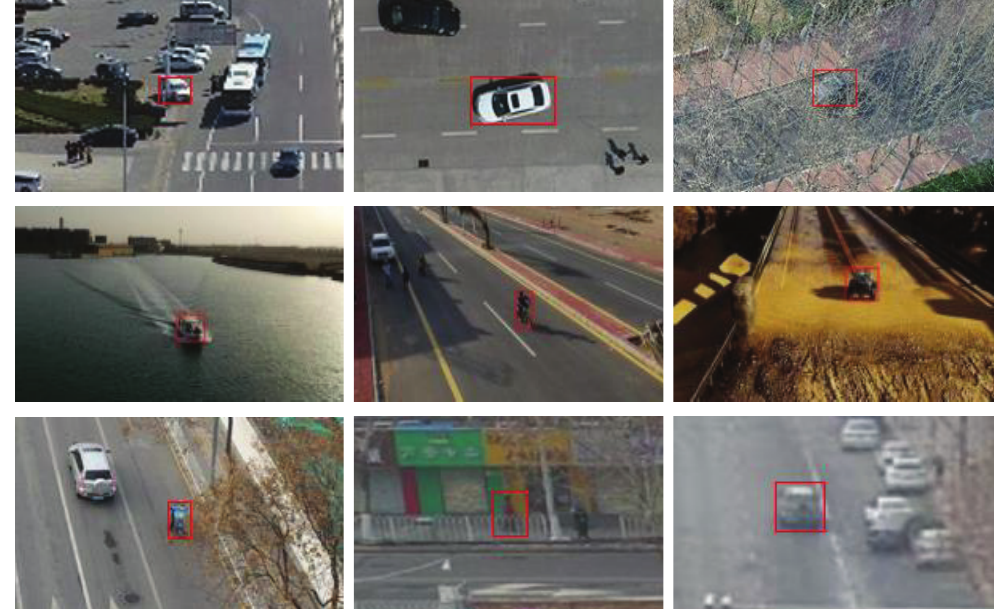
Figure 2. Due to the small size of objects, we use object areas instead of whole images to show differences of objects in UAVDT, UAV123, and VIPUOTB. We find that there are only various vehicles captured from real scenes in sequences from the UAVDT dataset shown in the first row. The sequences in UAV123 contain more comprehensive object categories and attributes. However, we can observe from the second row that there is a flat background and slight changes in most sequences of UAV123. Samples from our VIPUOTB are shown in the third row. We can see that the VIPUOTB dataset contains different kinds of objects, such as bicycles, pedestrians, and vehicles, compared with UAVDT. The backgrounds of sequences in our dataset are more complex than those of UAV123.